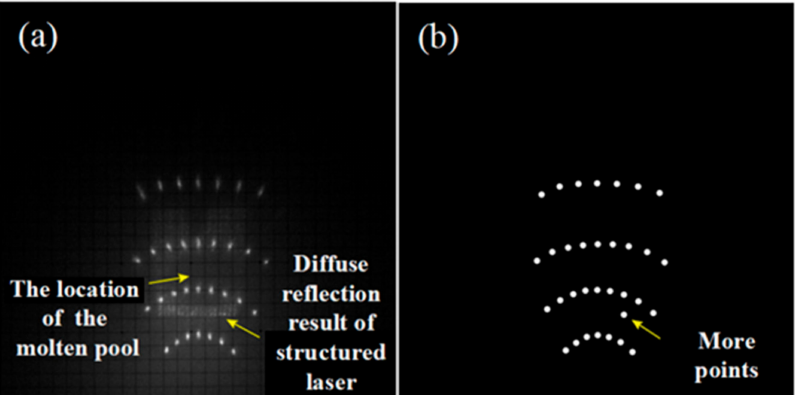
Figure 10. More points phenomenon caused by the presence of bright noise. ( a ) A reflection image taken early in the formation of the molten pool; ( b ) the image processing result of ( a